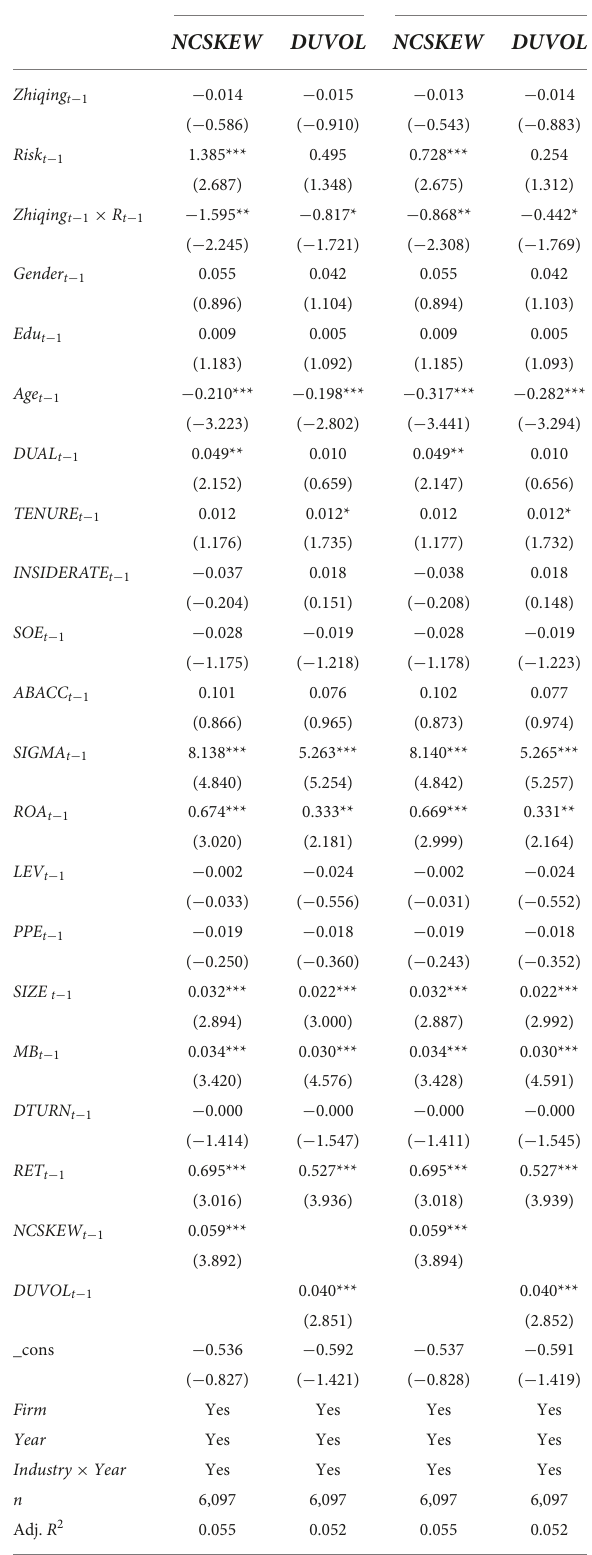
TABLE 11 Underlying mechanism test